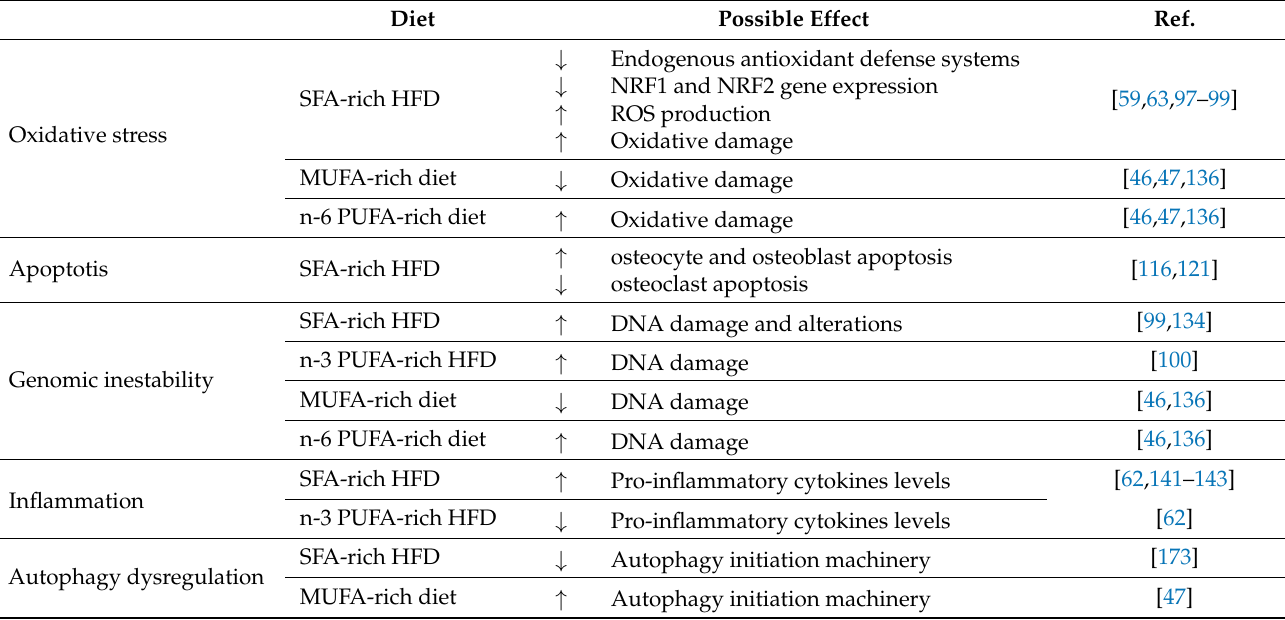
Table 3. Effects of dietary interventions modifying dietary fats on aging-associated mechanisms operating under the observed effects on bone